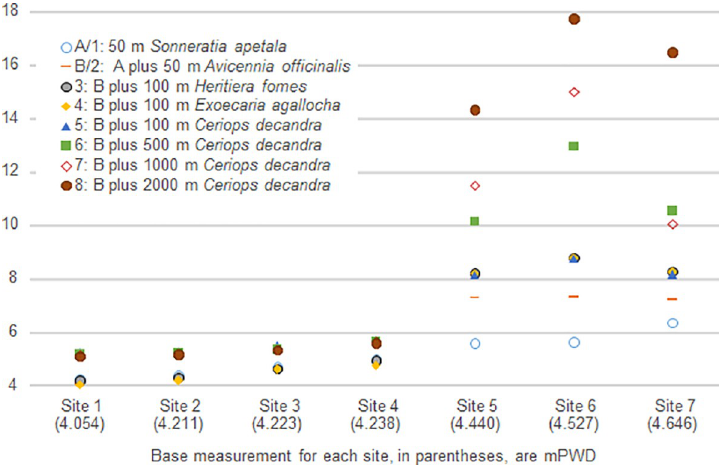
Fig 3. Attenuation of surge heights (cm) from afforestation of mangrove species at 5 m spacing.